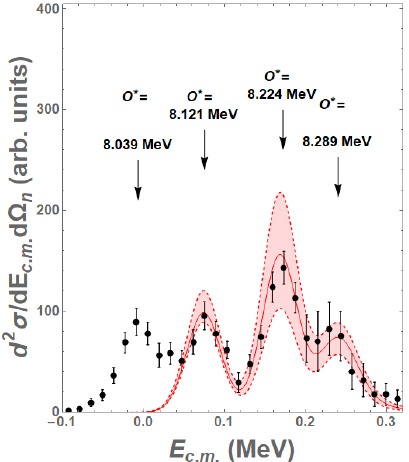
Figure 2 - ANC cross section compared with available THM data